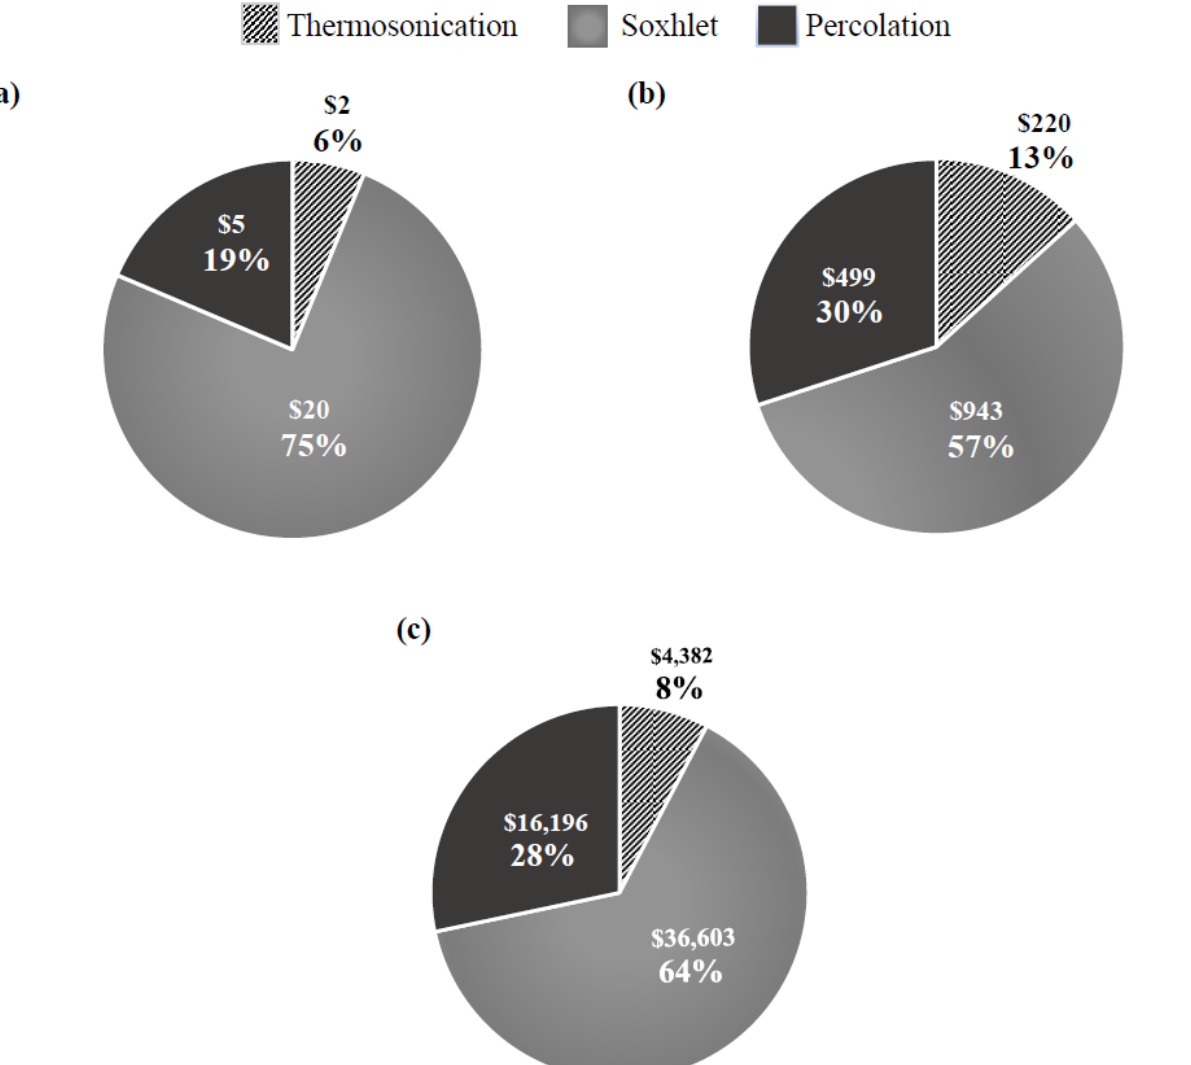
Figure 8. Electricity costs of each extraction technique to obtain: ( a ) 1 kg of fennel extract, ( b ) 1 kg of fennel dried solids, and ( c ) 1 kg of fennel phenolic compounds. Cost calculated considering the electrical energy price in Brazil per kWh (BRL 0.53) converted to dollars (USD 0.09). The cost of ethanol evaporation to obtain the dried solids and phenolic compounds was not considered.